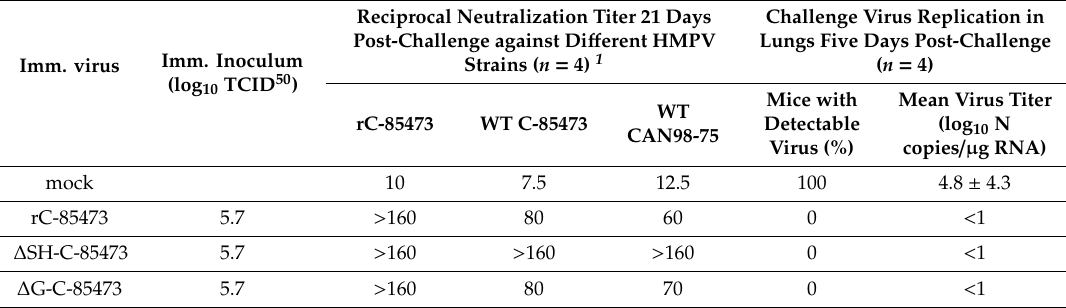
Figure 4. Weight loss, lung viral titers and histopathological scores of BALB / c mice infected with rC-85473-derived live-attenuated vaccines (LAV) candidates. BALB / c mice were intranasally infected with 5 × 10 5 TCID 50 of rC-85473 rHMPV viruses (WT, ∆ SH and ∆ G). ( A ) Weight loss was monitored during 14 days since infection ( n = 16). At 5 dpi, mice were euthanized and lungs were harvested to measure viral titers by both TCID 50 titration ( B ) and quantitative RT-PCR ( C ) ( n = 4). ( D ) Cumulative histopathological scores (bronchial, peribronchial, perivascular, interstitial, pleural and intra-alveolar inflammation scores) of other infected mouse lungs were evaluated at 5 dpi ( n = 5). Data are shown as means ± SEM. * p < 0.05, ** p < 0.01, *** p < 0.001 when comparing each ∆ SH / ∆ G virus to its WT counterpart using repeated measures two-way ANOVA. Table 2. Immunogenicity and protective e ffi ciency of HMPV C-85473-derived viruses in